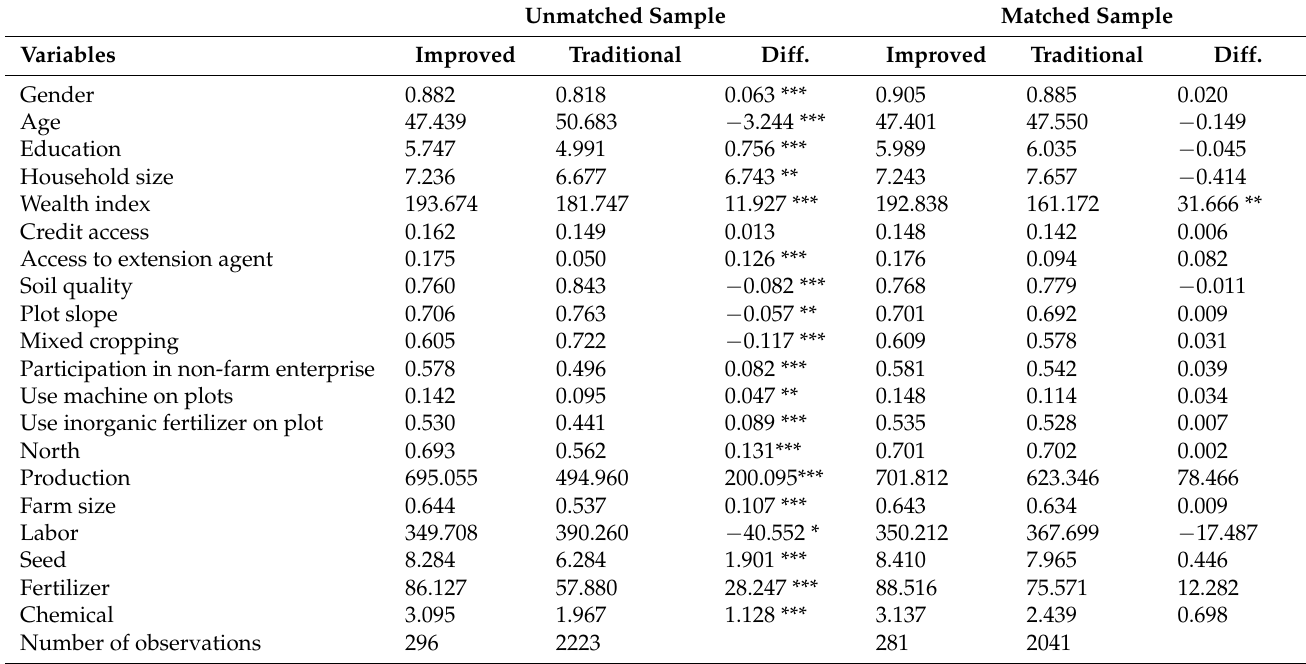
Table 2. Mean differences in characteristics between matched and unmatched improved and tradi- tional